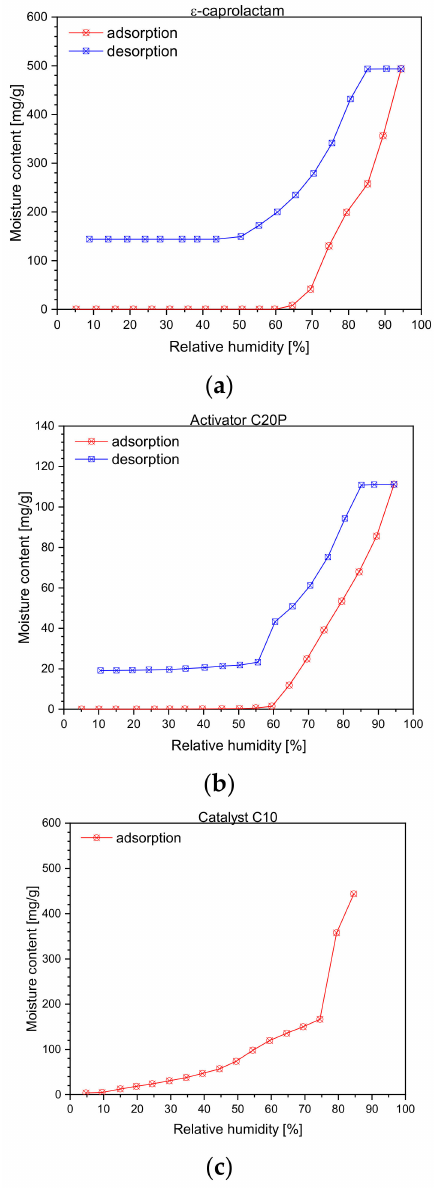
Figure 2. Sorption isotherms at 23 ◦ C of ( a ) ε -caprolactam, ( b ) activator BRUGGOLEN ® C20P and ( c ) catalyst BRUGGOLEN ®